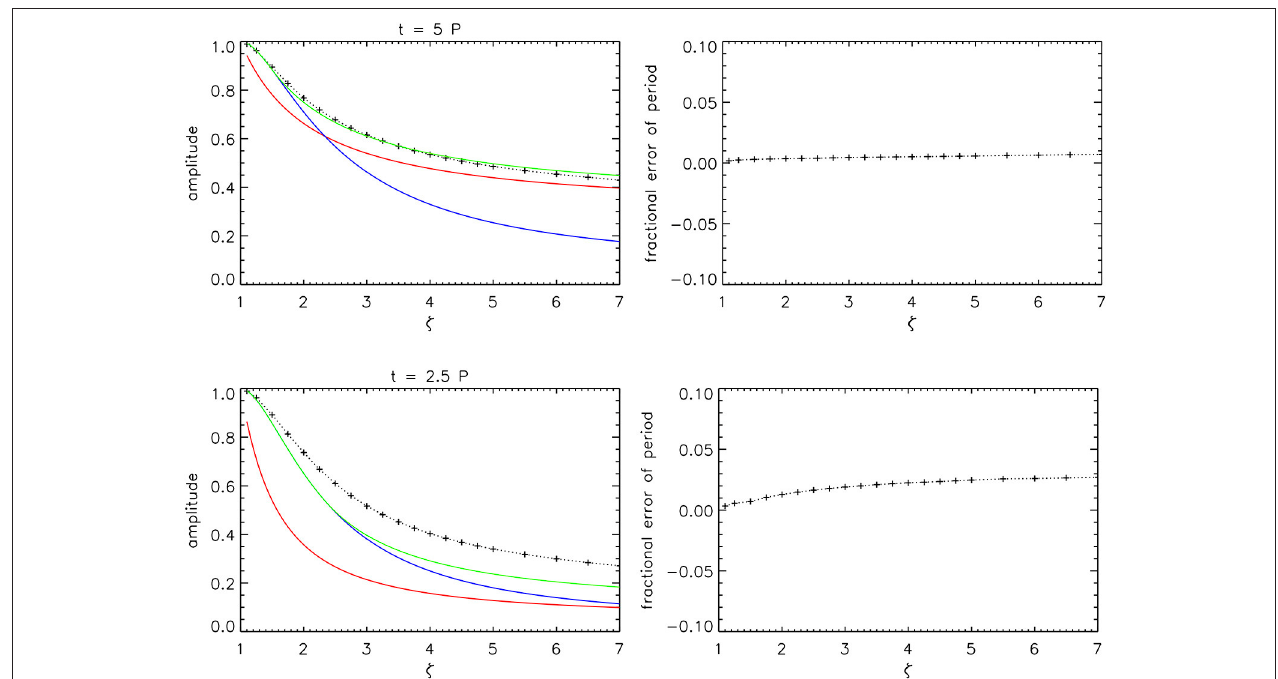
FIGURE 3 | Dependence of the damping of the kink oscillation on the density contrast ratio ζ . The top panels show results for ǫ = 0.1 and the bottom panels for ǫ = 0.5. The left panels show the kink oscillation amplitude (plus symbols) taken at a fixed time ( t = 5 P or 2.5 P ) The colored lines show the estimates based on the general damping profile (green), Gaussian damping profile (blue), and exponential damping profile (red). The right panels show the variation of the period of oscillation compared with the theoretical value P k